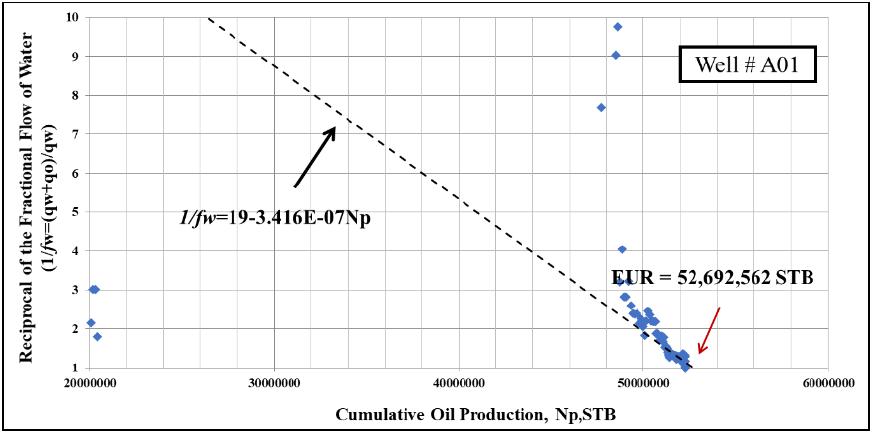
Figure 17. Reciprocal of fractional flow of water versus cumulative oil production for well A01